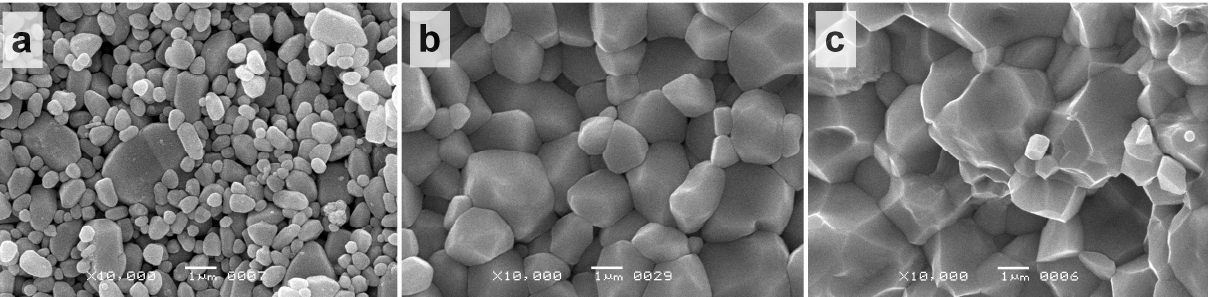
Figure 13. SEM images of ZnO ceramics prepared from powder impregnated by 0.5 wt.% ZnAc ( a ), 2.5 wt.% ZnAc ( b ), 5.0 wt.% ZnAc ( c ) and underwent TVT (case of 2P sealing type during CSP).